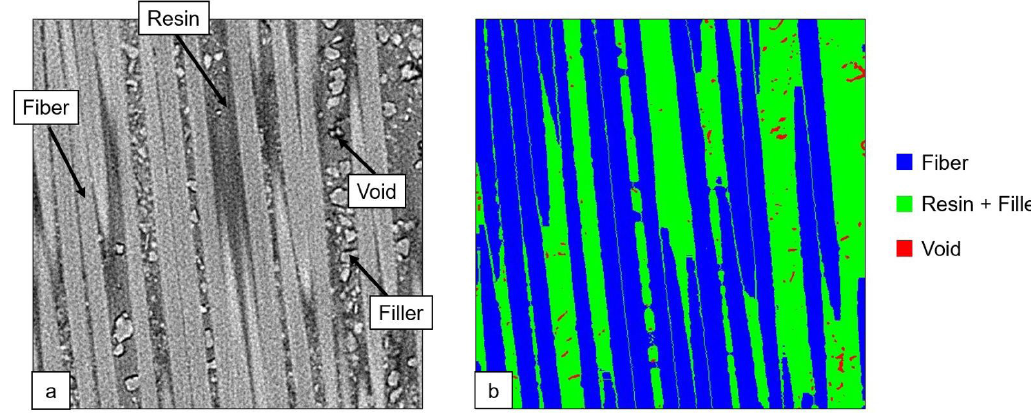
Figure 12. Result of segmentation of the roving layer: (a) original image; (b) segmented image.